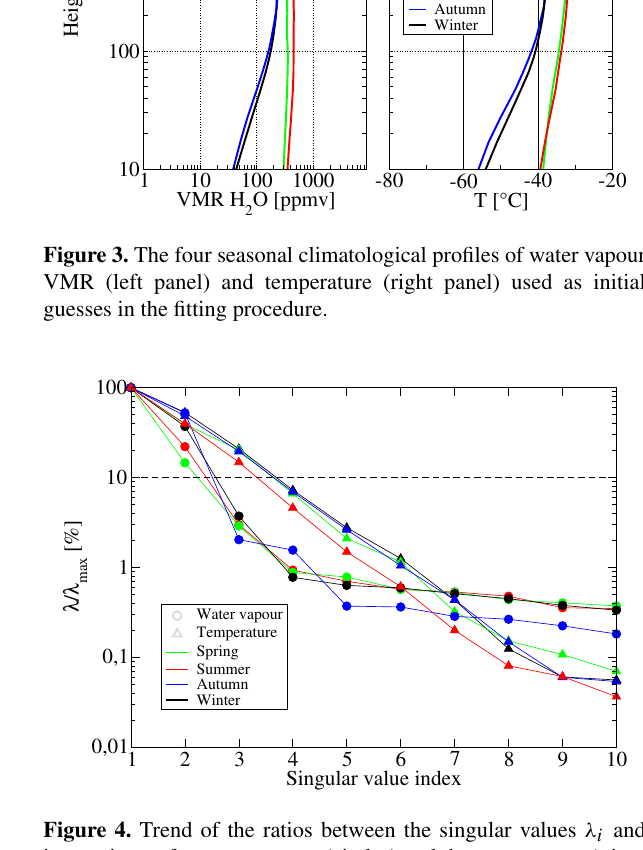
Figure 4. Trend of the ratios between the singular values λ i and its maximum for water vapour (circles) and the temperature (trian- gles). The threshold used to select the singular independent states is represented by the black